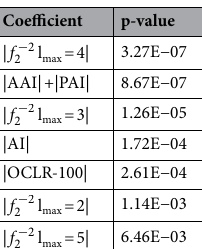
Table 2. p-values for the different coefficients and indexes computed ordered from highest to lowest